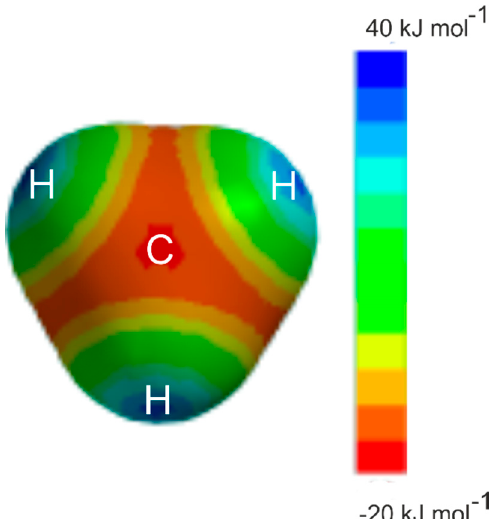
Figure 1. The molecular electrostatic surface potential of CH 4 at the 0.001 e / bohr 3 isodensity surface, as calculated at the MP2 / 6-311 ++ G** level of theory. The view is along a C 3 axis of the molecule. The deepest red region along this axis is at the face centre (almost exactly beneath the C symbol), indicating a nucleophilic (negative, − 20 kJ mol − 1 ) region of electrostatic potential energy. There are clearly paths to the other three equivalent regions that are only slightly less nucleophilic (orange, − 15 kJ mol − 1 ) than the face centre region. The blue areas indicate electrophilic regions known as sigma holes (positive + 40 kJ mol − 1